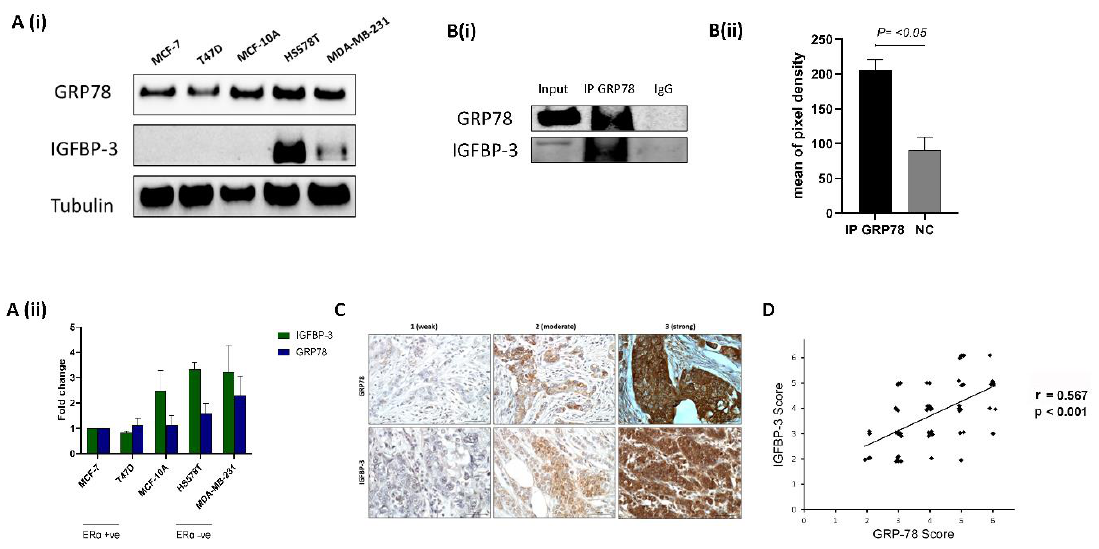
Figure 1. GRP78 and IGFBP-3 co-operate ( A,i ) The levels of GRP78 and IGFBP-3 were examined using Western blotting of the whole cell lysates from the nonmalignant MCF-10A cells and various breast cancer cell lines. ( A,ii ) Quantification of Western blot results shown in ( A,i ). ( B,i ) Hs578T cell extract was subjected to IP with either control IgG or GRP78 antibodies and the samples immunoblotted with GRP78 and IGFBP-3 antibodies. Input represents whole cell lysate as a percentage of protein amount (12.5%) used for the IP reaction. ( B,ii ) Quantification of IP results presented in ( B,i ). ( C ) Representative images of GRP78 and IGFBP-3 IHC staining (1 = weak; 2 = moderate; 3 = strong) in paraffin-embedded breast cancer tissue sections ( n = 69). IHC scores of GRP78 and IGFBP-3 abundance are shown in ( D ) Nonparameter Spearman correlation co-efficiency and the p value are also shown. The whole blots (uncropped blots) are shown in the Supplemental Materials.